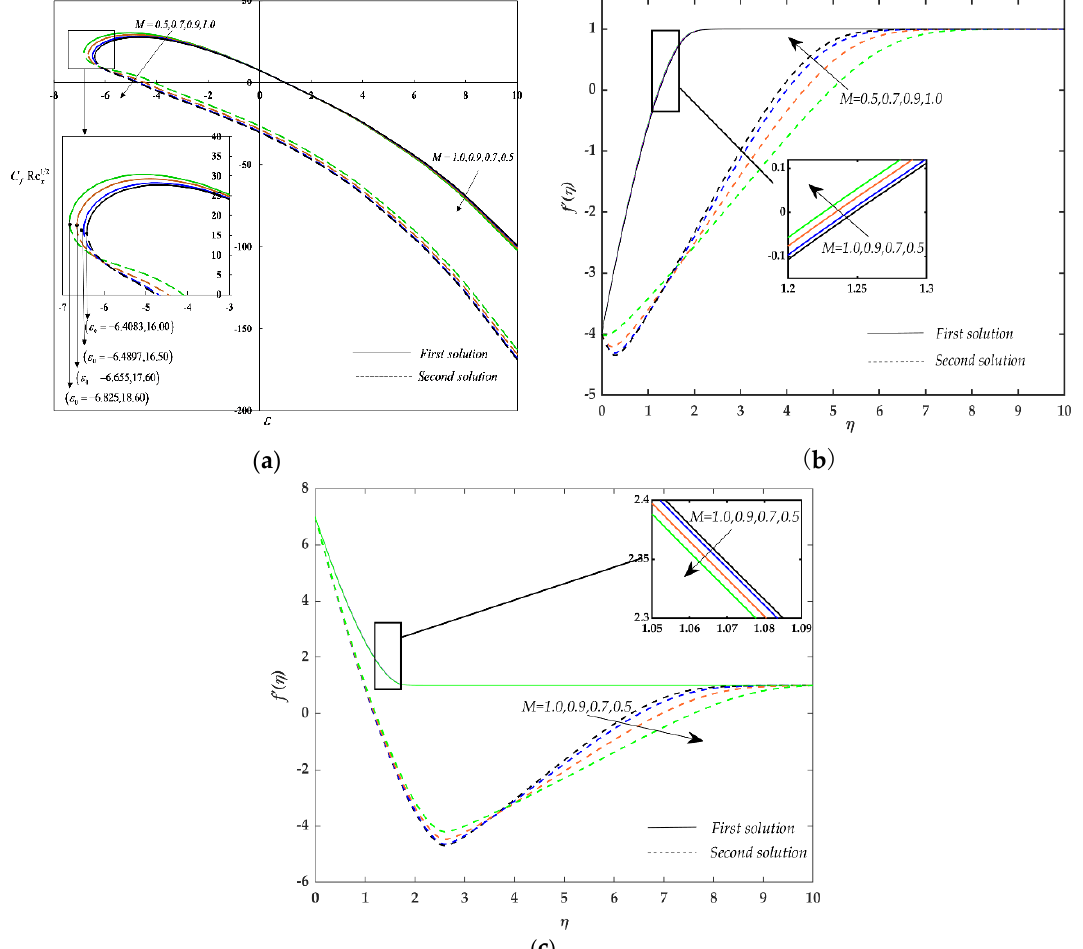
Figure 4. Impact of the magnetic parameter ( M ) on: ( a ) the reduced skin friction coefficient; ( b ) velocity profiles as M varies past a shrinking sheet ( ε = − 4 ) ; ( c ) velocity profiles as M varies past a stretching sheet ( ε = 7 ) when Rd = 1.2, m 0 = 1.5,Pr = 4.36, De = 1.5, s = 7, and φ = 0.02. Figure 5 portrays the e ff ect of the nanoparticle volume fraction or φ on C fx Re 1/2 and velocity x profiles. The increment in φ increases the values of C fx Re 1/2 over a permeable shrinking x